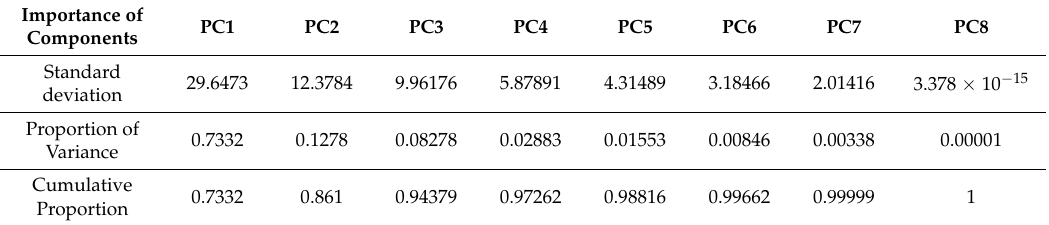
Table 3. Coefficients of Poisson regression.